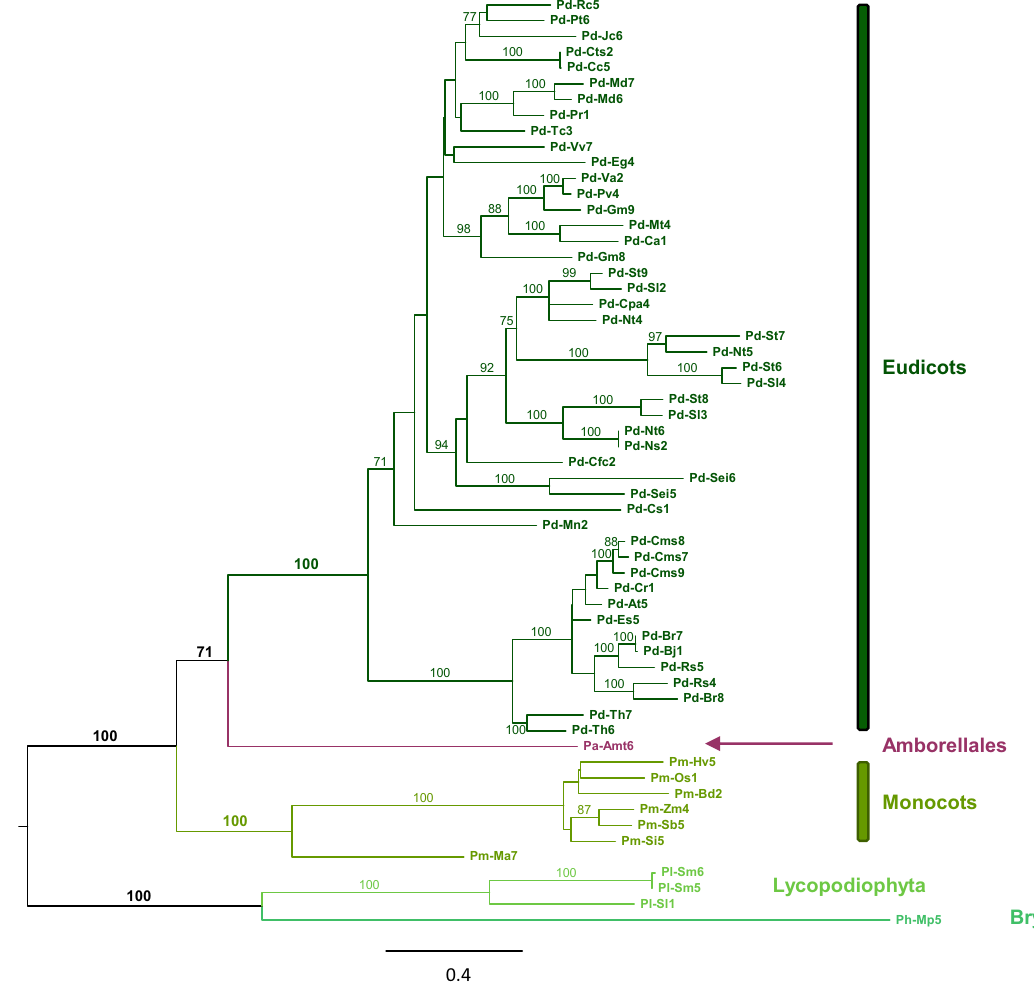
Figure 4. Maximum likelihood phylogeny of plant PAOs of the AtPAO5-like clade (see Fig. 2) based on 59 amino acidic sequences. Bootstrap values of support (BS) are reported along the branches (BS >